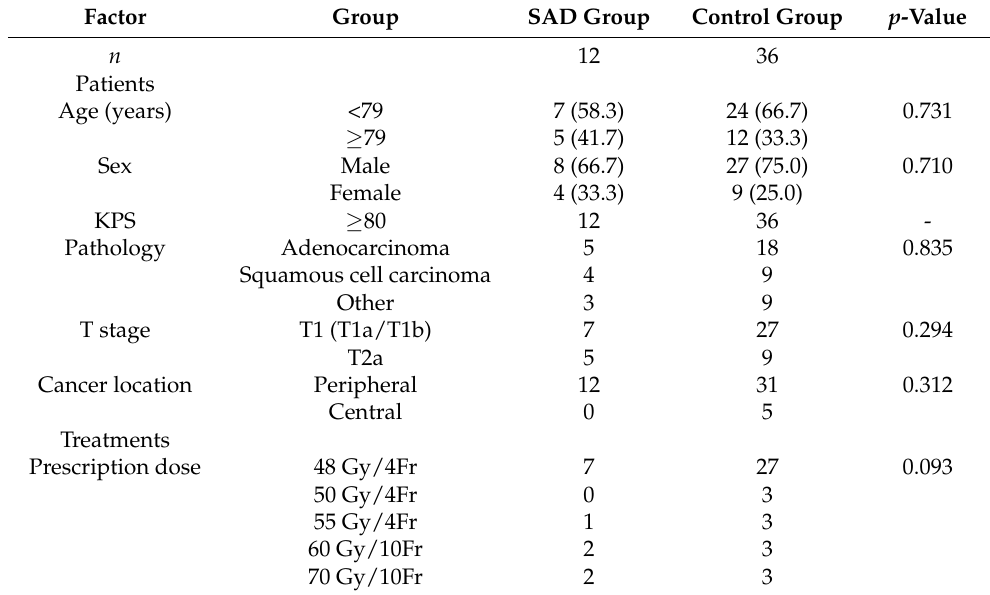
Table 1. Patient characteristics.